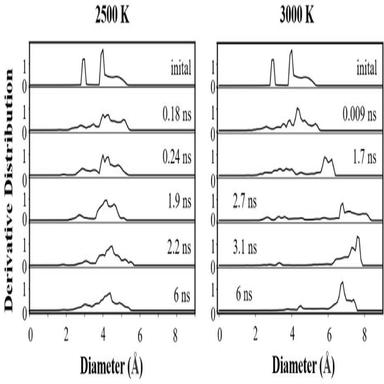
The pore size distribution (PSD) diagrams with time in the C60 conversion products. The results were obtained by using a probe with a diameter of 0.5 Å.